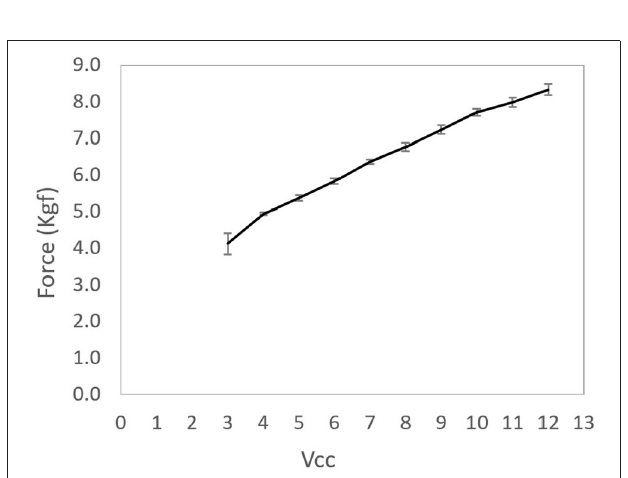
FIGURE 9 | Average of the actuating force per actuator voltage supply. Error bars presented in the figure represent the standard deviations of each mean.